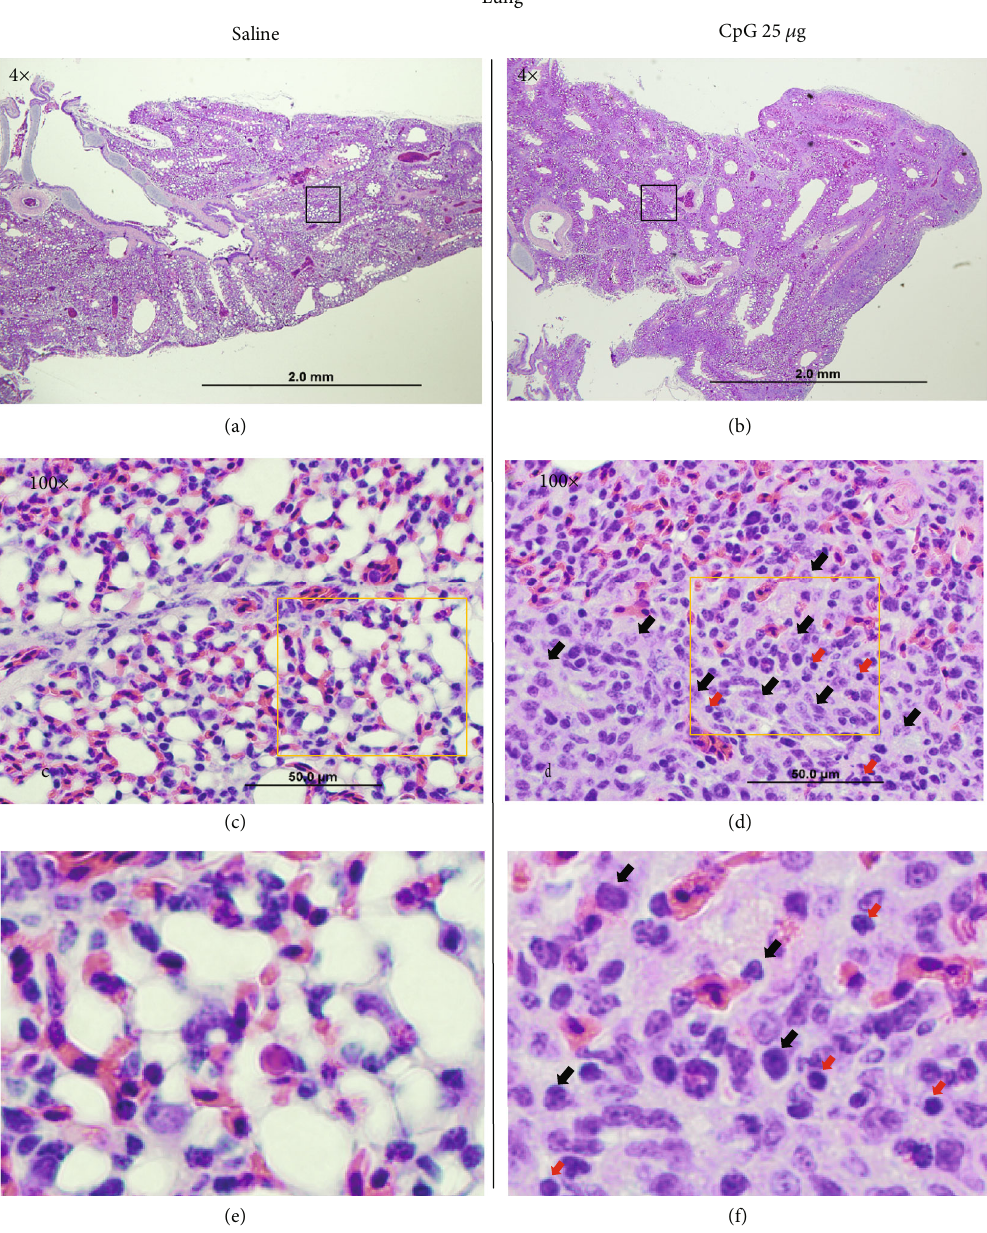
Figure 2: Histology of the lung. Hematoxylin and eosin staining 72 hrs post in ovo injections revealed higher cellular in fi ltration in the lungs of birds treated with 25 μ g CpG-ODN compared to saline control. Higher cellular in fi ltration was seen with CpG-ODN treatment (b) compared to saline (a) in low power (4x). High power magni fi cation (100x) (d) and the magni fi ed inset (f) showed that these cells mainly comprised of a mononuclear (macrophages) cell population (black arrows) and lymphocytes (red